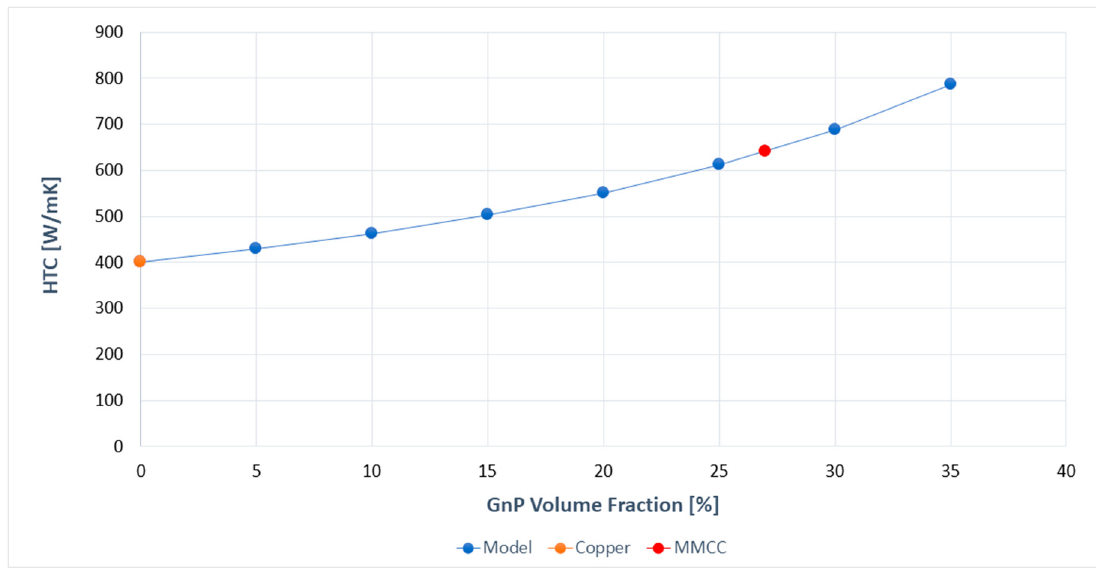
Figure 7. Calculated in-plane thermal conductivity enhancement for GnP-MMCC by the EMA model depending on the filler volume fraction in comparison with the experimental data obtained by the flash method.